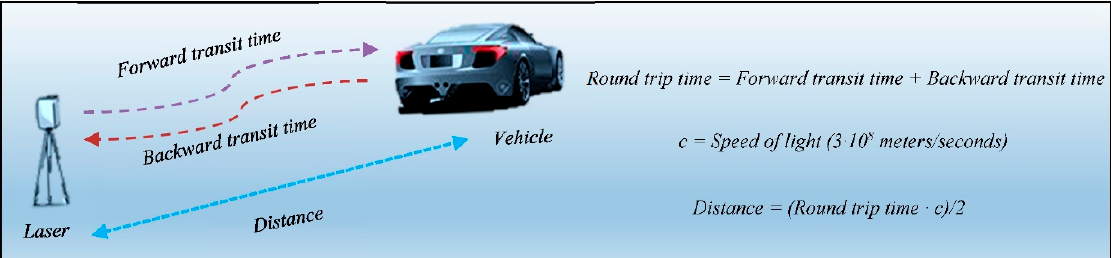
Figure 1. Operation of a laser sensor.